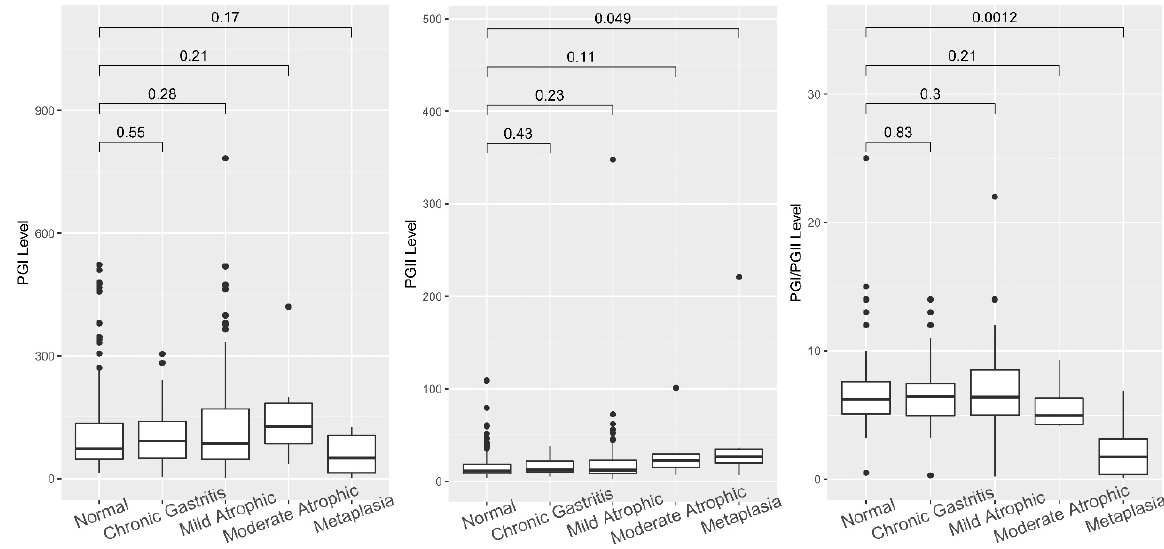
Figure 4. PGI, PGII, and PGI/PGII ratio among the different histology status groups. The PGI levels among groups were not significantly different. However, a significant difference in PGII and PGI/PGII ratio was observed between the normal and metaplasia groups.